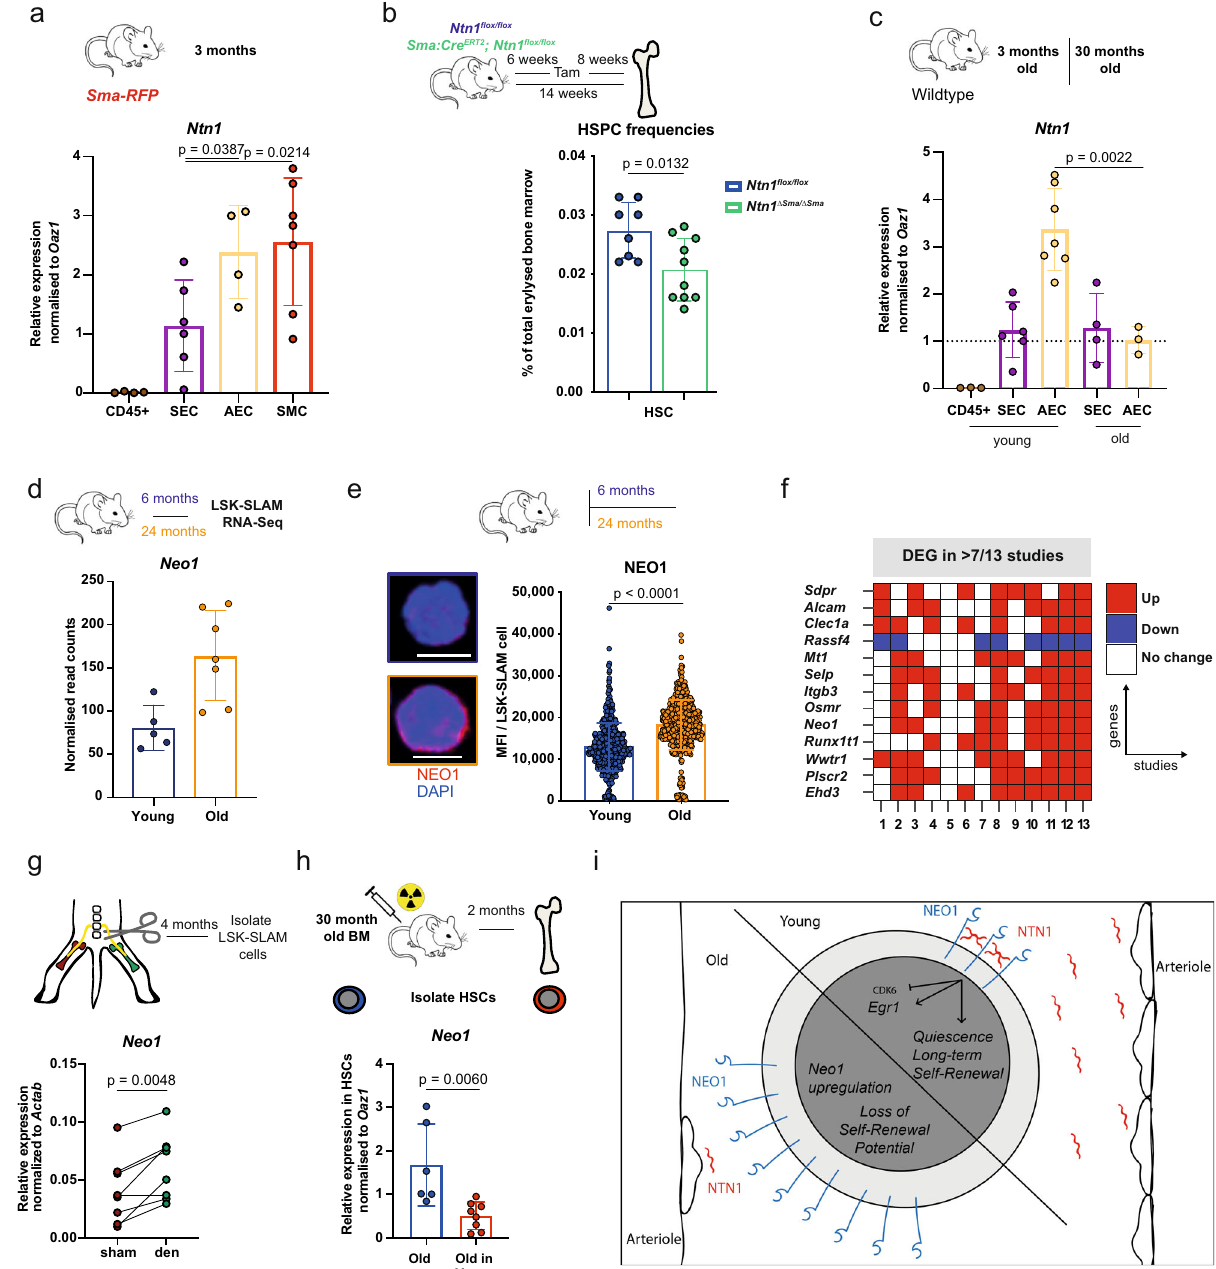
Fig. 7 Loss of niche-derived Ntn1 induces Neo1 in HSC upon ageing. a Relative expression of Ntn1 in CD45 + cells, SEC, AEC and RFP + SMC derived from Sma-RFP mice; n = 4 (CD45/AEC), 6 (SEC) and 7 (SMA-RFP), two independent experiments. b Frequencies of HSCs in bone marrow of in Ntn1 fl ox/ fl ox and Ntn1 Δ Sma/ Δ Sma mice; n = 8 ( fl ox) and 10 ( Δ SMA), three independent experiments. c Relative expression of Ntn1 in SEC, AEC and CD45 + cells derived from young and old Wt mice; n = 3 (yCD45/oAEC), 4 (oSEC), 6 (ySEC) and 7 (yAEC), three independent experiments. d Normalized read counts of Neo1 in young, and old LSK-SLAM cells; n = 5 (young) and 7 (old), FDR < 0.0001. e MFI of NEO1 in sorted 6 or 24 months LSK-SLAM cells; n = 592 (young) – 593 (old). f Most abundant common DEGs in published ageing studies and own data, additional details in the “ Methods ” section. g Relative expression of Neo1 in LSK-SLAM cells isolated from either denervated or healthy legs of individual mice; n = 8, two independent experiments. h Relative expression of Neo1 in HSCs of aged mice, before and after 2 months post transplantation; n = 6 (before) and 8 (after), two independent experiments. i Model of Neo1/Ntn1 axis in young and old mice. For all panels, ±SD is shown. n indicates biological replicates. Scale bars in IF images are 5 μ m. P value determined by two-tailed t test unless stated otherwise. Source data are provided as a Source Data fi